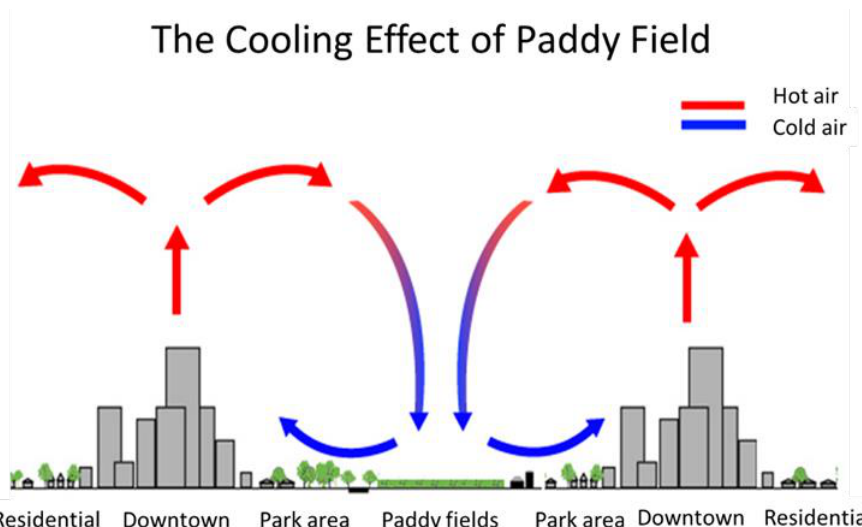
Figure 1. Paddy field cooling effect: a schematic diagram of changes of cold air and hot air. Source: Chiueh et al. (2015) [13].